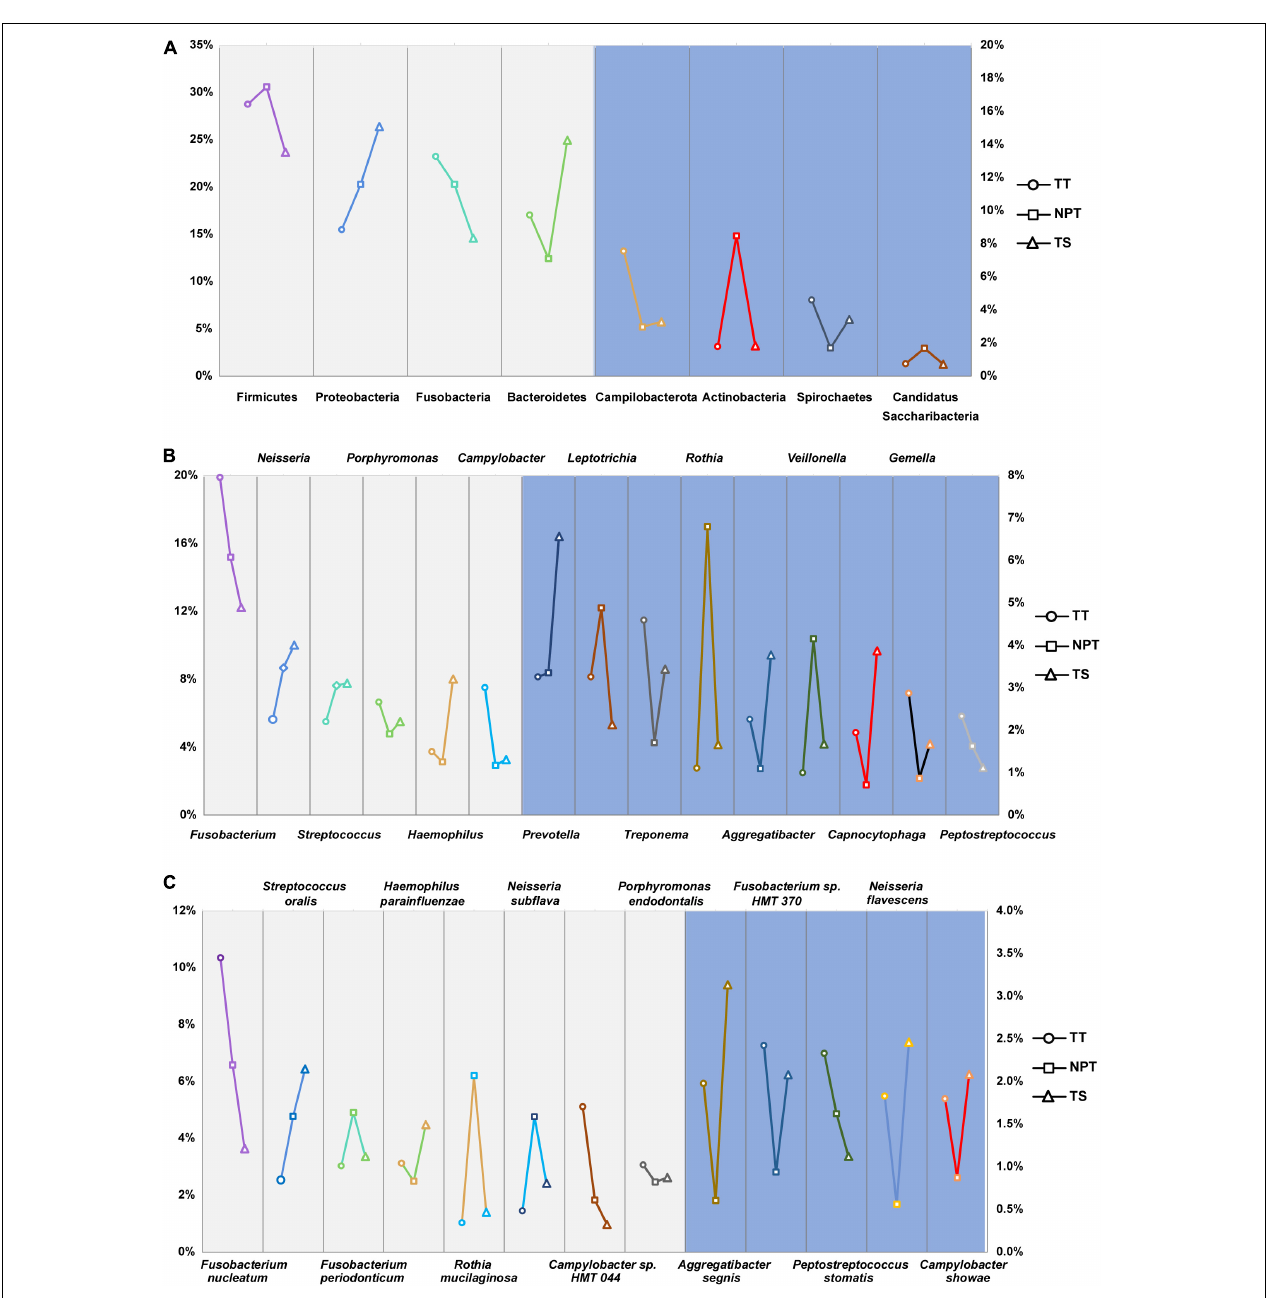
FIGURE 2 | The proportion of major phyla (A) , genera (B) , and species (C) in the TT, NPT, and TS of OSCC patients. The relative abundance of taxa labeled in light gray was indicated by the left ordinate, and that labeled in light blue was indicated by the right